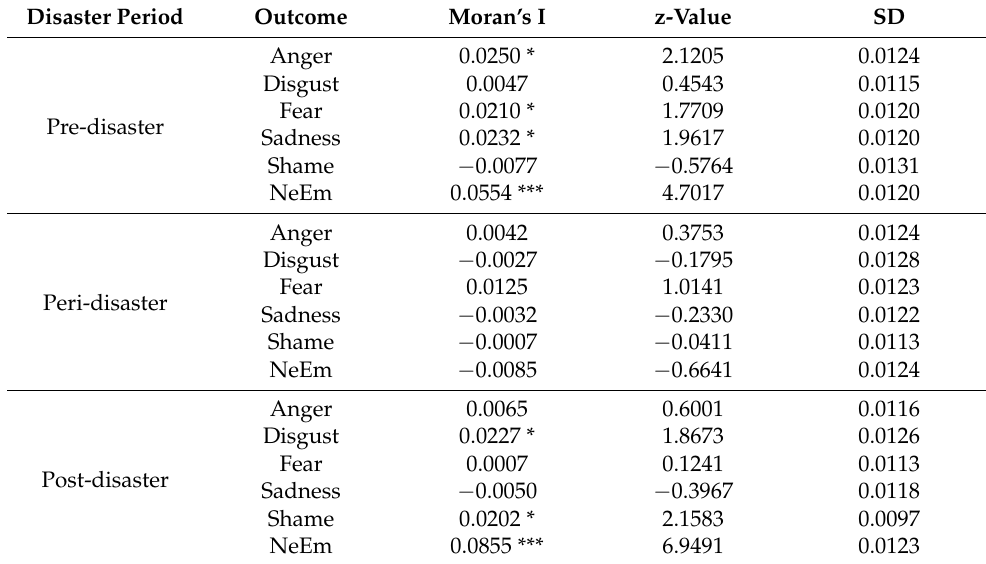
Table 1. Global univariate Moran’s I for negative emotions across three disaster periods. SD = Stan- dard Deviation, NeEm =combined negative emotions. Significance values: *** <0.001, ** <0.01, * <0.05,